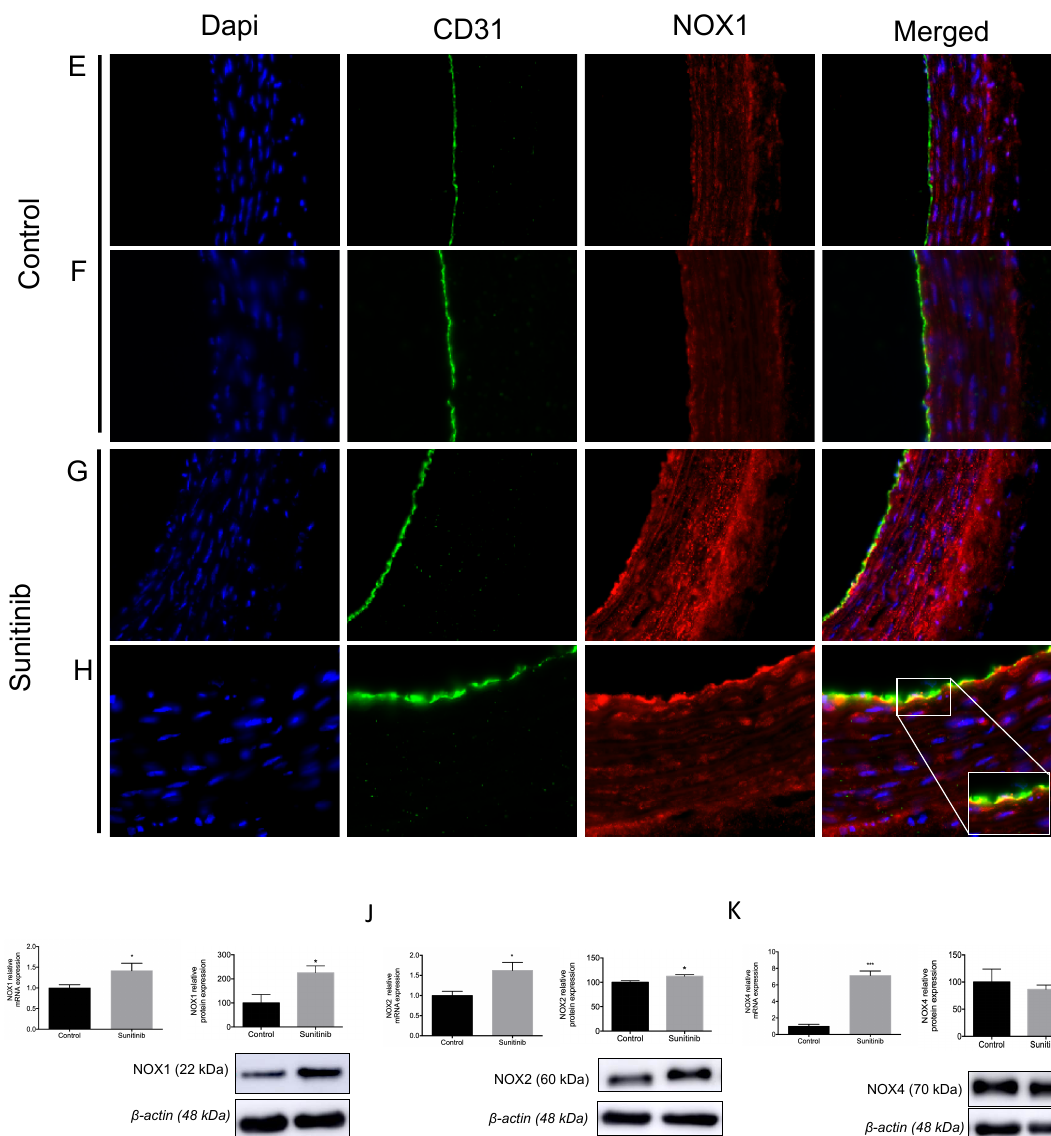
Figure 6. Double immunostaining of NOX1 (red) and α -SMA (VSMCs) (green) ( A – D ), and NOX1 (red) and CD31 (green) ( E – H ), in aortas from control and sunitinib-treated (25 mg / kg / day) animals. Magnifications: 40 × ( A , C , E , G ) and 100 × ( B , D , F , H ). ( I – K ) Protein and mRNA expression of NOX1 ( I ), NOX2 ( J ), and NOX4 ( K ). Values are expressed as mean ± S.E.M. of eight animals per group. * p < 0.05; *** p < 0.001 vs. control